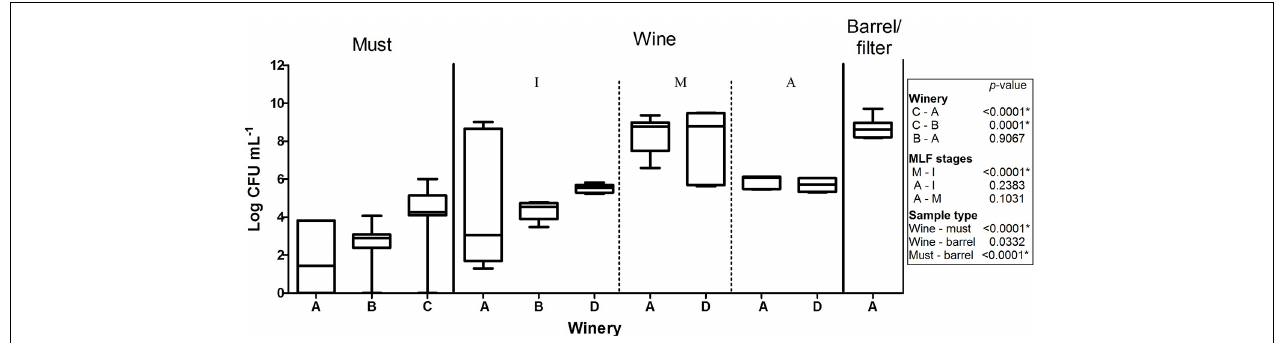
FIGURE 1 | Population of lactic acid bacteria in samples of must, barrel/filter and wine throughout three stages of malolactic fermentation: I beginning, M intermediate, A advanced; obtained from wineries (A–D). Kruskal–Wallis analysis and Dunn’s post hoc test among wineries, MFL stages and sample type. The box indicates the 25th and 75th percentiles, line across the box shows the median value and the whiskers caps represent the maximum and minimum values.